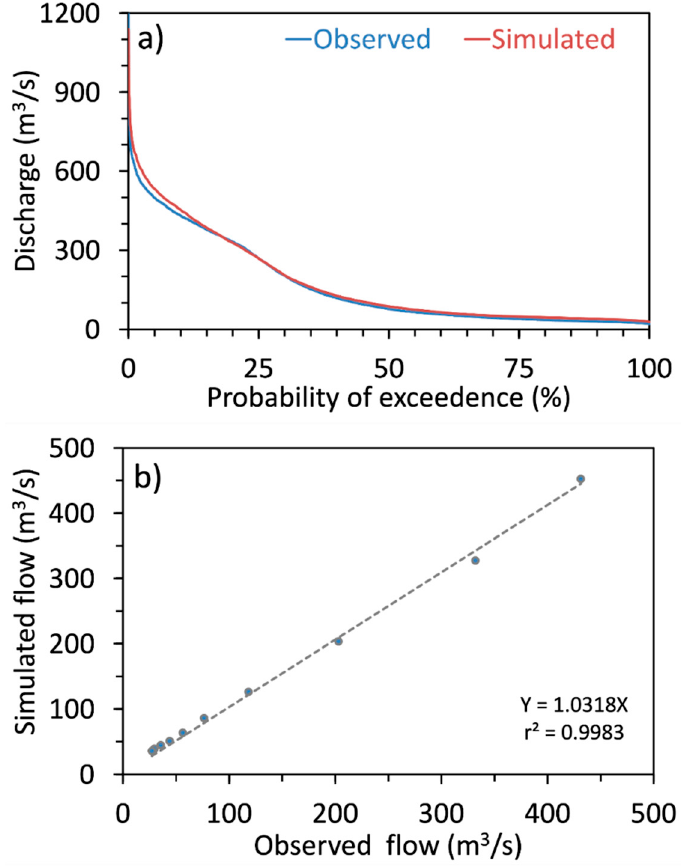
Figure 8. ( a ) FDC of observed and simulated flows, and ( b ) relationship between observed and simulated exceedance flow at 10 percentile intervals.